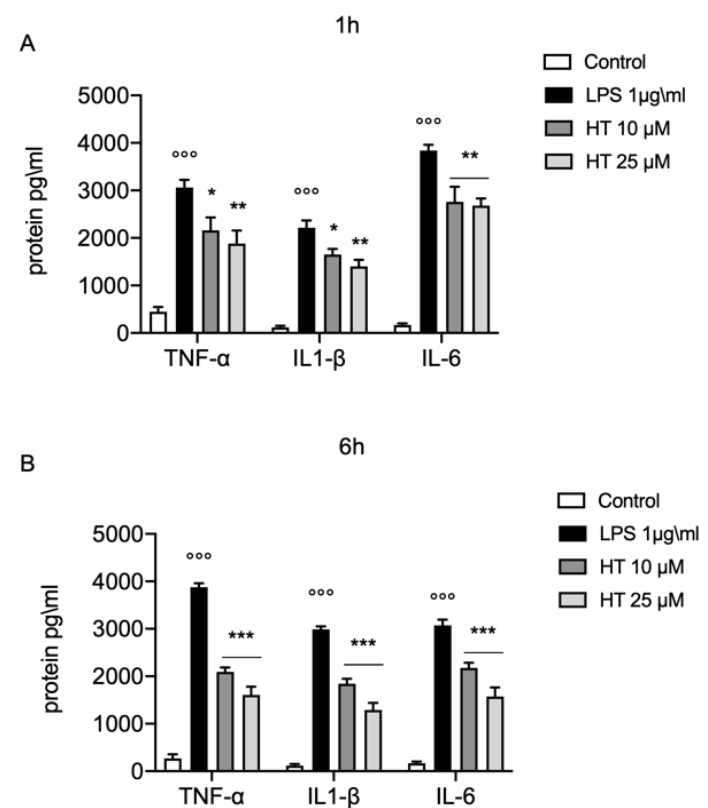
Figure 3. Protective e ff ect of HT in LPS induced inflammatory response in MAC-T cell. ( A ) TNF- α , IL-1 β and IL-6 levels one hour after LPS-stimulation 1 µ g / mL; ( B ) TNF- α , IL-1 β and IL-6 levels six hours after LPS-stimulation 1 µ g / mL. Data representative of at least three experiments, means ± SEM; ◦◦◦ p < 0.001 vs. control; * p < 0.05 vs. LPS; ** p < 0.01 vs. LPS; *** p < 0.001 vs. LPS.